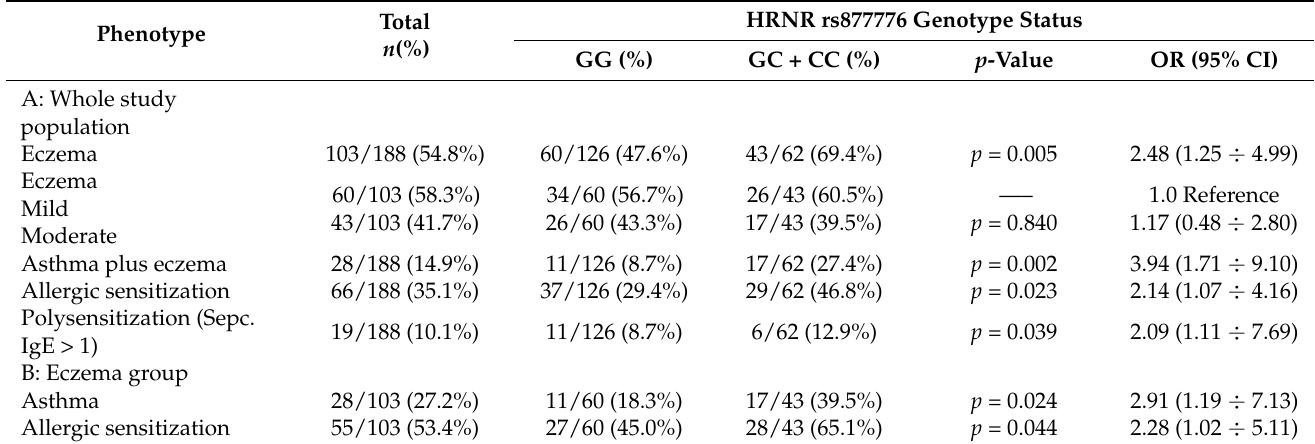
Table 2. Associations between the HRNR rs877776 genotype and allergic diseases.